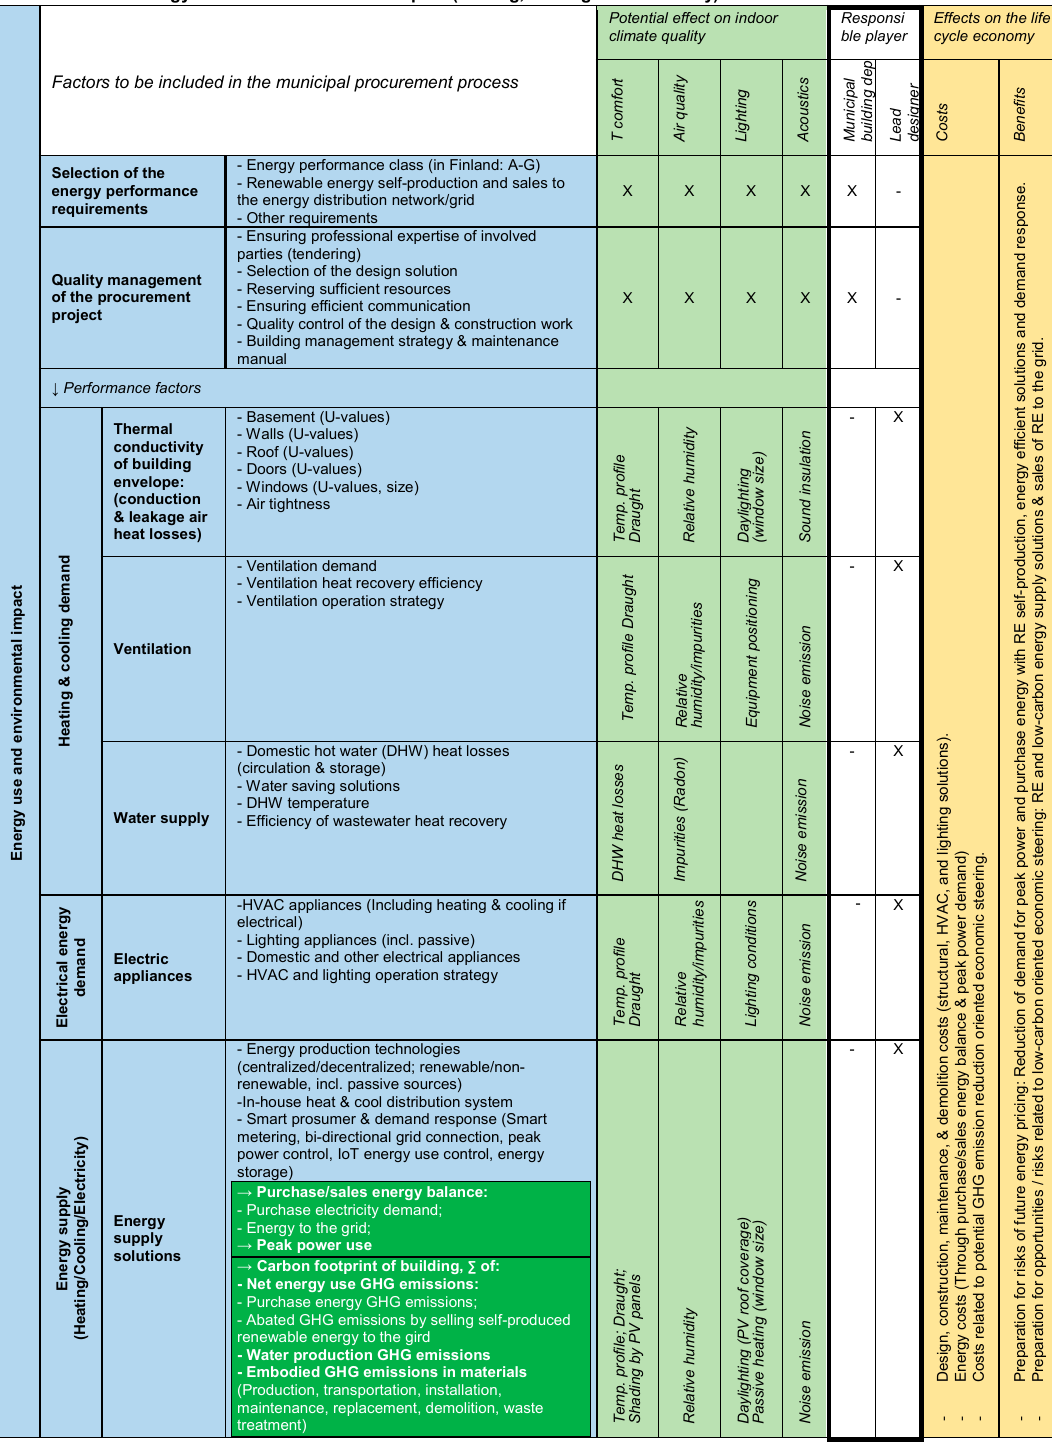
Figure 9. The energy efficiency responsibilities in the design of the municipal building: Energy use and the environmental impact of a building. Based on